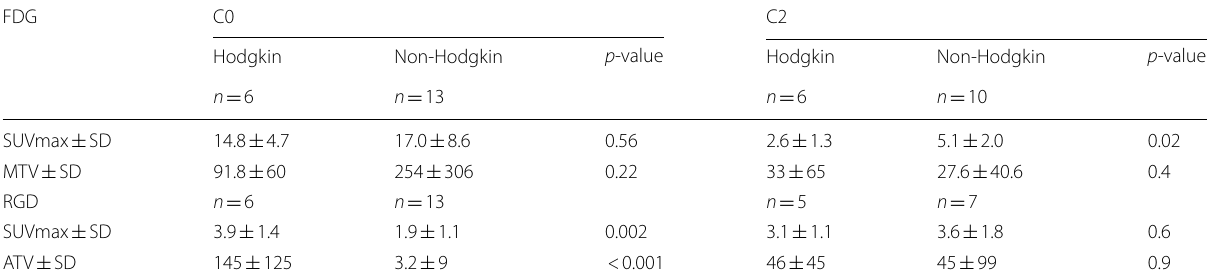
Table 2 FDG and RGD uptake in Hodgkin and non-Hodgkin patients before (C0) and after (C2) chemotherapy FDG C0